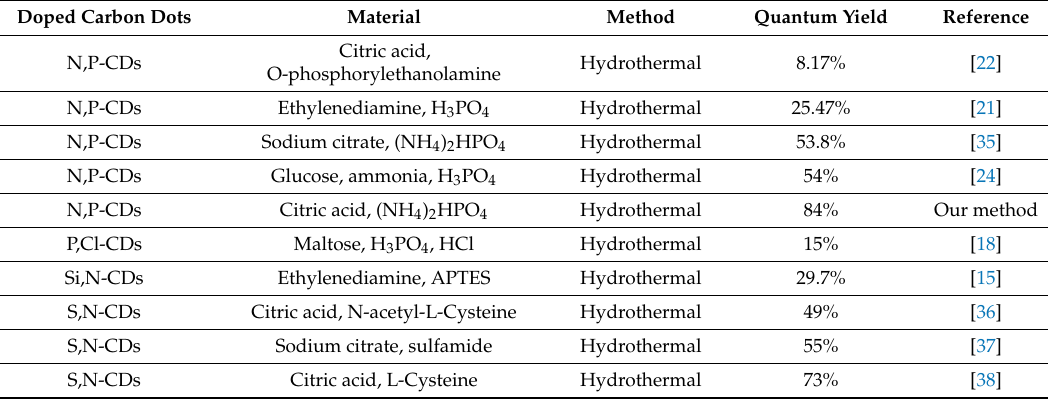
Figure 1. ( A ) Excitation (a 1, a 2 ) and emission (b 1 , b 2 ) fluorescence spectra of the CDs and NPCDs (inset: enlarge fluorescence spectrum of CDs), ( B ) fluorescence spectra of the NPCDs in the range of excitation wavelength from 280 to 390 nm. Table 1. Comparison of QY of co-doped CDs synthesized using different methods. Table 1. Comparison of QY of co-doped CDs synthesized using di ff erent methods. Doped Carbon